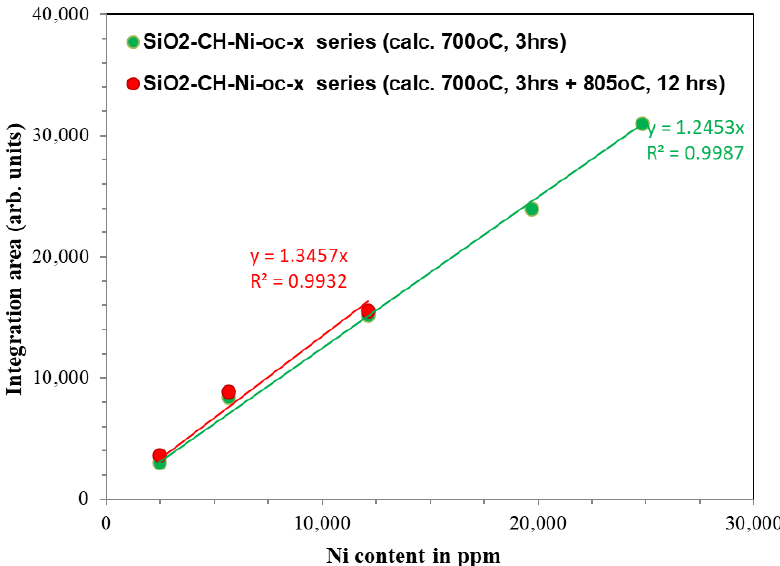
Figure 5. Effect of calcination severity on the correlation of the integrated intensity of the (2 0 0) reflection of NiO (bunsenite) versus Ni content for the same series of Ni-loaded SiO 2 samples (linear fit was calculated with zero intercept).